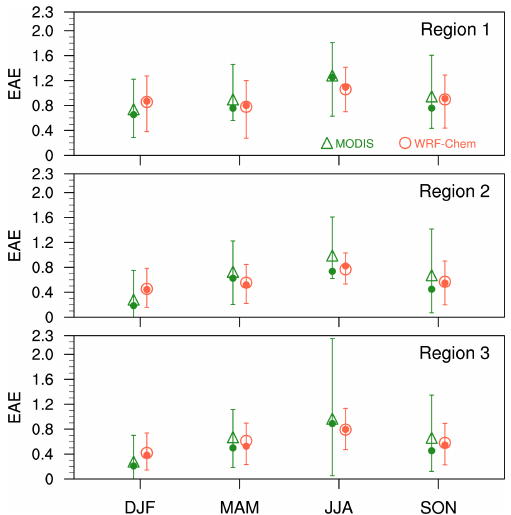
Figure 8. Seasonal mean EAE from the MODIS retrievals and the corresponding WRF-Chem simulation averaged for the period 2010–2014 over the three sub-regions shown in Fig. 4. The vertical bars represent 10th and 90th percentile values, the filled dots rep- resent the median values, and the triangles and circles represent the mean values.